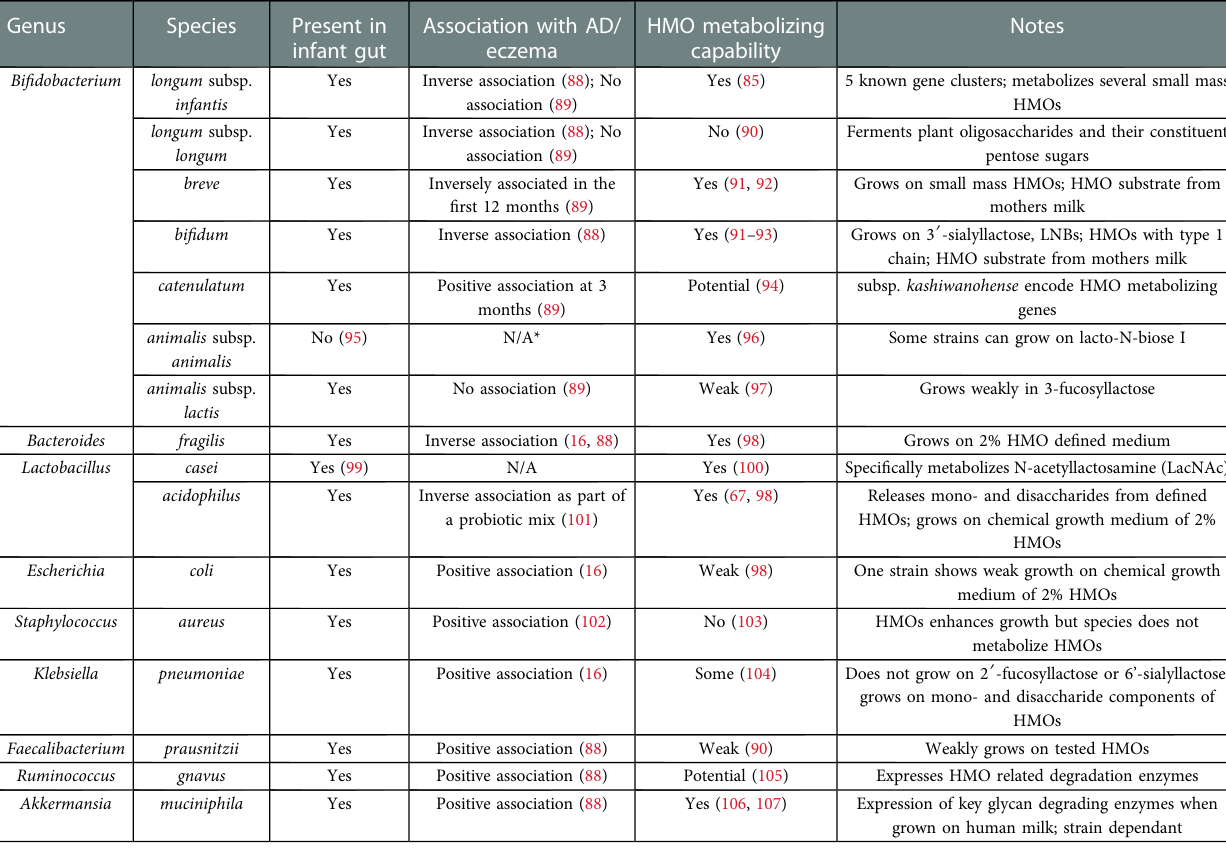
TABLE 2 Select bacterial species and their association with AD/eczema and HMO metabolizing capacity.